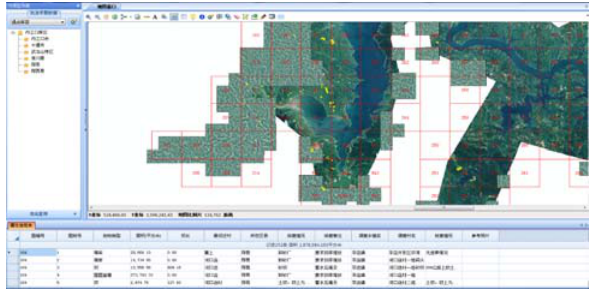
Figure 3. Monitoring information maintenance